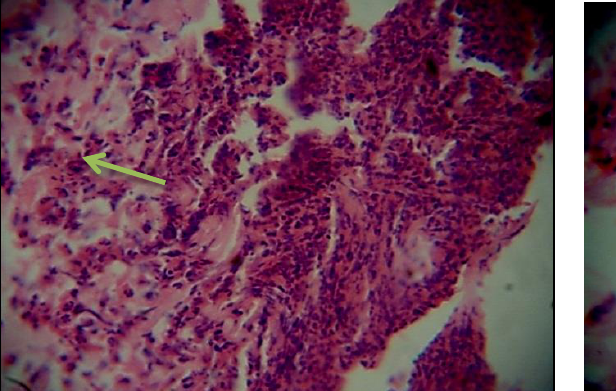
Figure, 9: Shows hemorrhage and neutrophils infiltration in the dermis and between muscles fiber , 3 days post operation treated group (H &E 40 X).